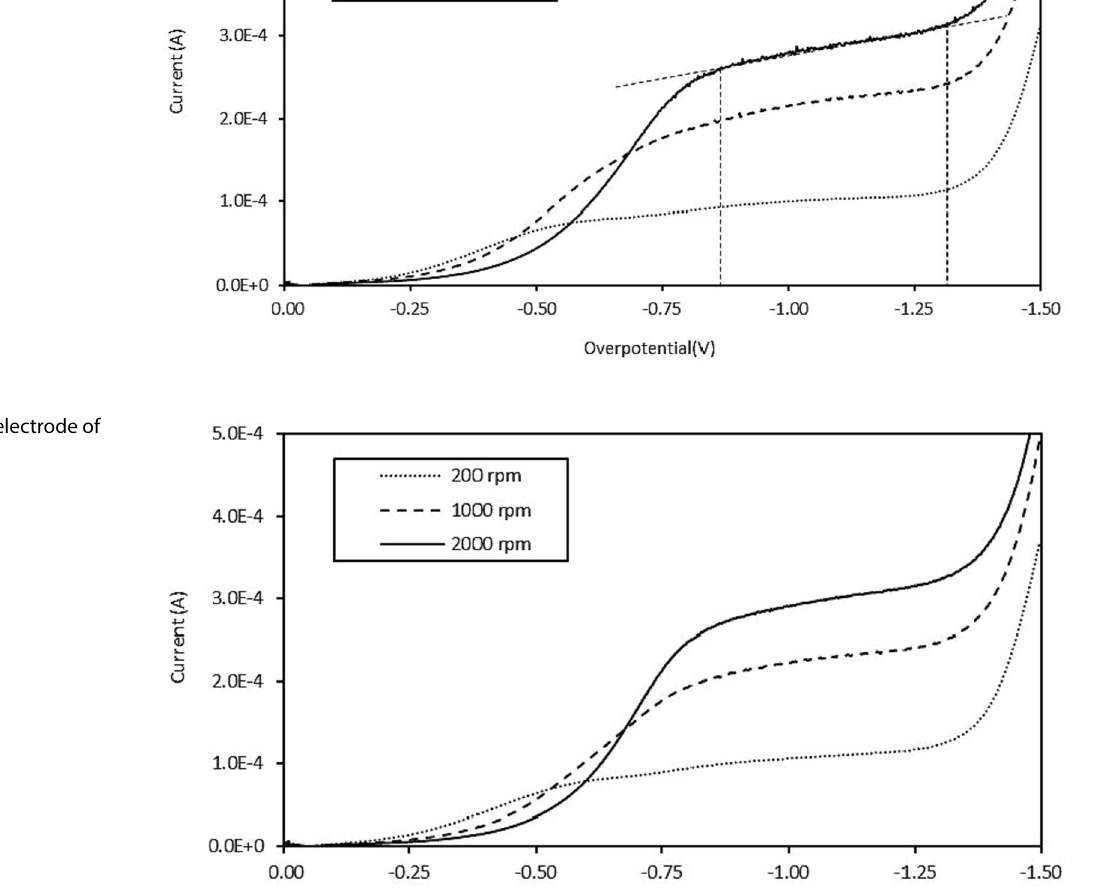
Fig. 8 IV curve for electrode of P-308-Mn, and determination of plateau region